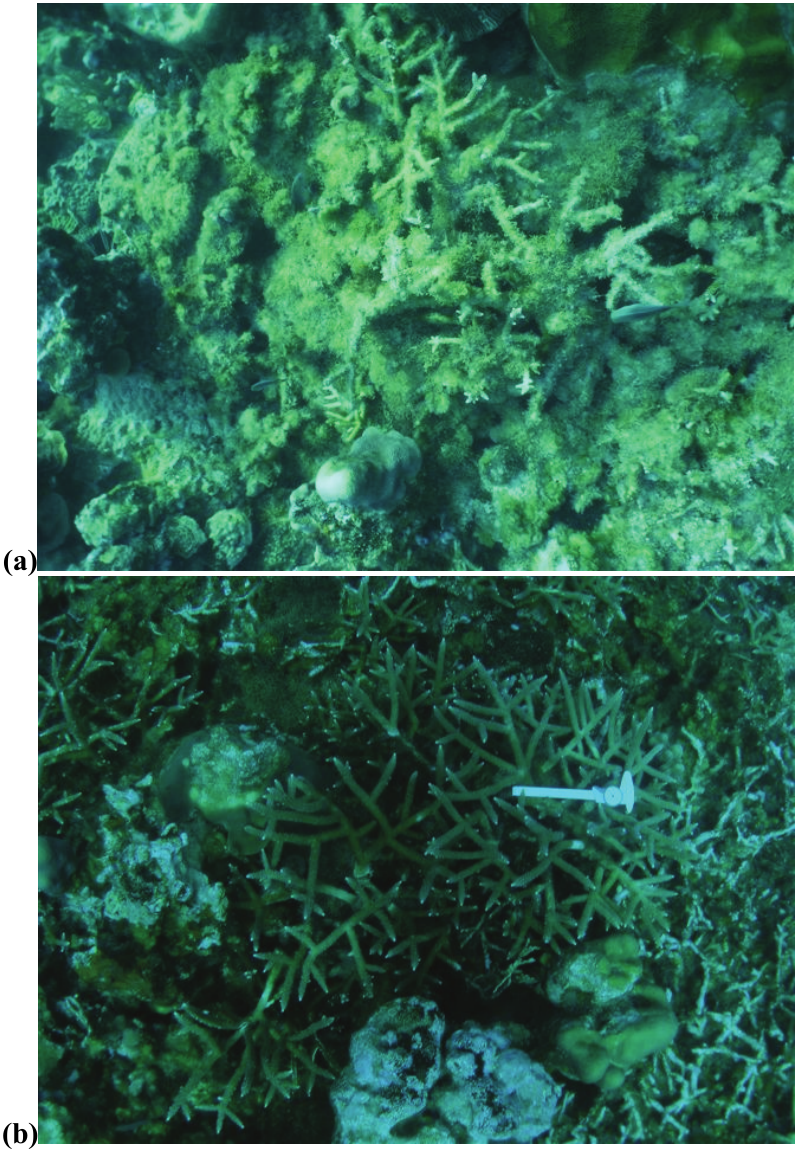
Figure 4. Acropora cervicornis colonies at Dairy Bull reef. (a) Complete bleaching